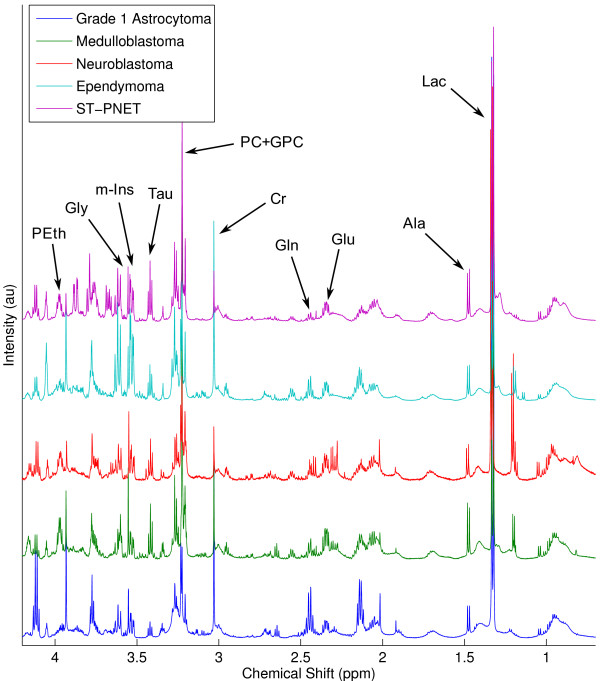
HR-MAS spectra. High resolution magic angle spinning 1H NMR spectra for the five tumour groups studied. Spectra were baseline corrected [36] and then scaled to the spectral area between 0.5 ppm and 4.5 ppm. Tau – Taurine, PEth – phosphorylethanolamine, PC – phosphorylcholine, m-Ins – myo-inositol, Lac – lactate, Gly – glycine, GPC – glycerophosphorylcholine, Gln – glutamine, Glu – glutamate, Cr – creatine.